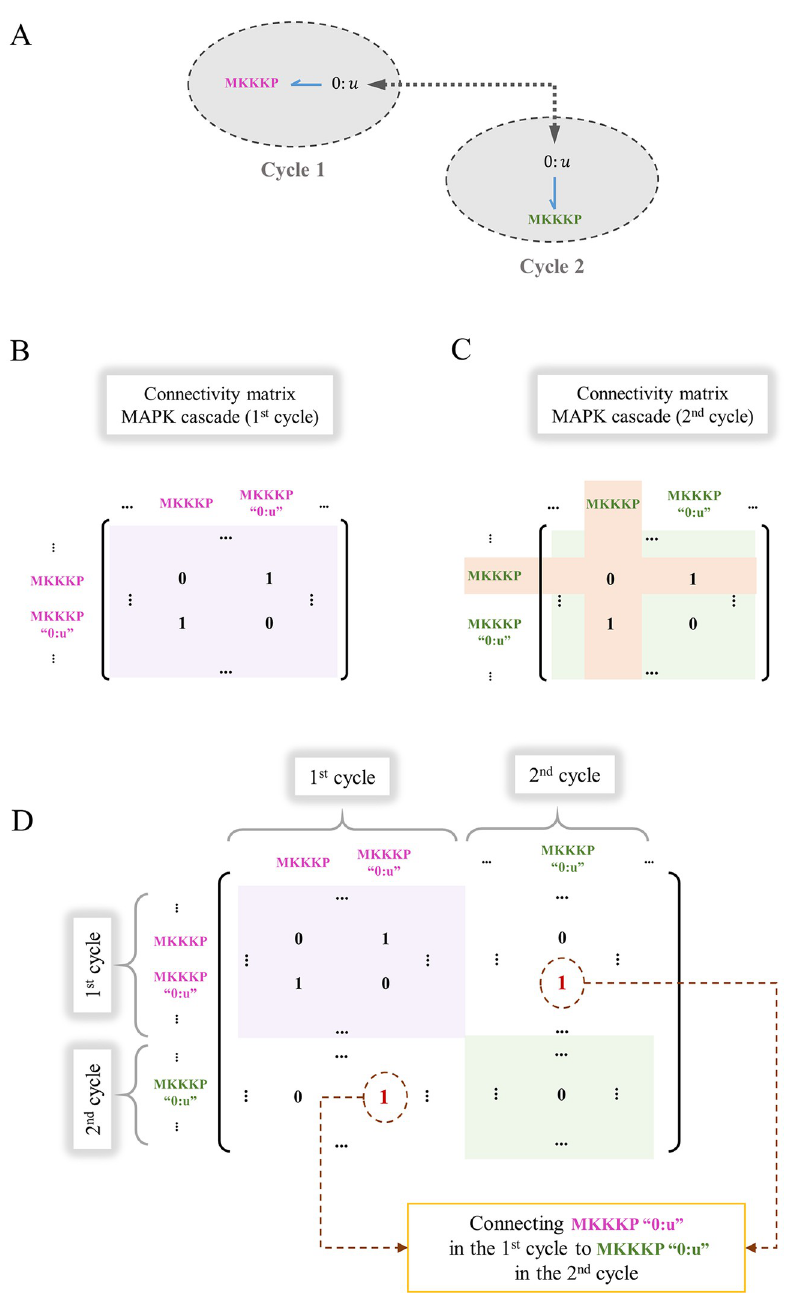
Fig 8. Construction of the whole-system connectivity matrix for a composed model. The procedure is illustrated by integrating two connectivity matrices (1 st and 2 nd cycles in the MAPK cascade). Initially, the two cycles had identical connectivity matrices. (A) MKKKP is a common component between the first and second cycle; (B) The connectivity matrix for the 1 st cycle; (C) The modified connectivity matrix for the 2 nd cycle where the row and column for the common component (MKKKP) will be removed; (D) The placement of the connectivity matrices for each module on the diagonal of the whole-system connectivity matrix. The pink and green boxes indicate the connectivity matrices for the 1 st and 2 nd cycles, respectively. The corresponding ‘0:u’ junctions for MKKKP in the two cycles are connected by inserting two 1s (in red) to represent a bond between them (bidirectional connections between the components require the matrix be